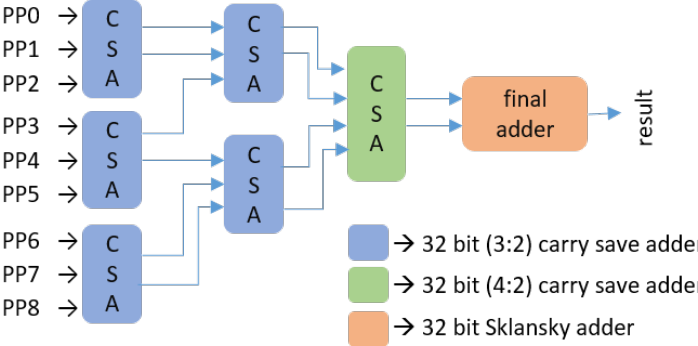
Figure 8. Wallace tree structure for the summation of partial products. All CSAs and final adder are approximate.